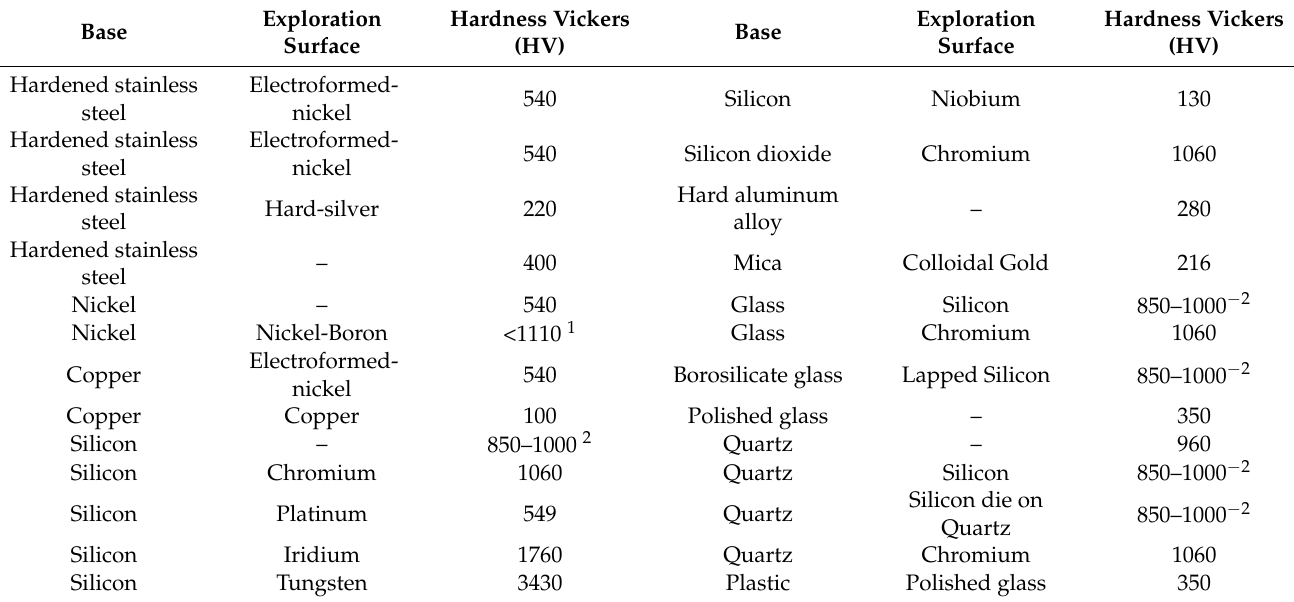
Table 1. Common materials for roughness